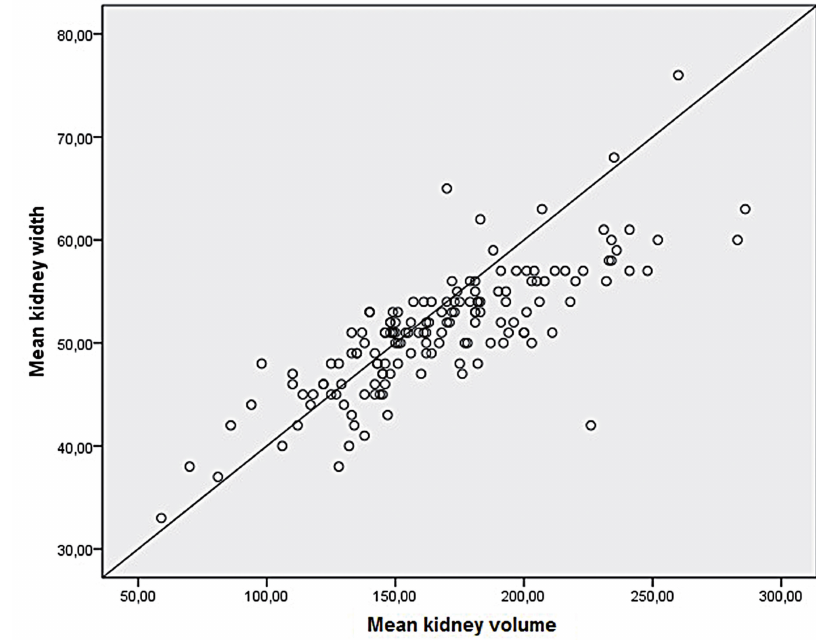
Figure 5 - Relation between mean kidney volume (cm 3 ) and kidney width